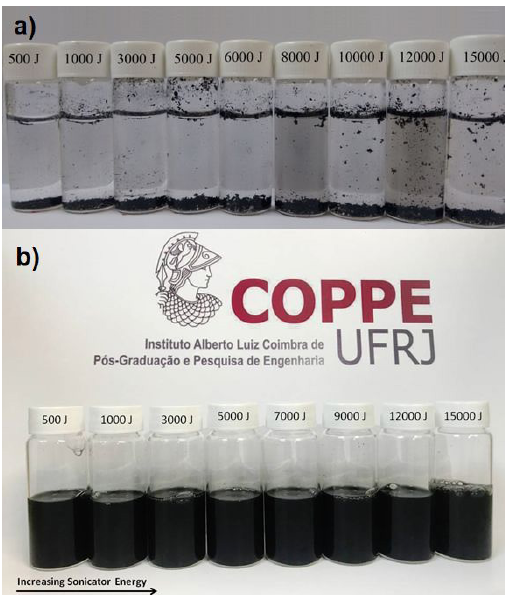
Figure 3. Photographic record of MWCNT dispersions in water 30 min after sonication with different energies: without (a) and with (b) the use of 0.5 wt.% of Triton X-100 surfactant.